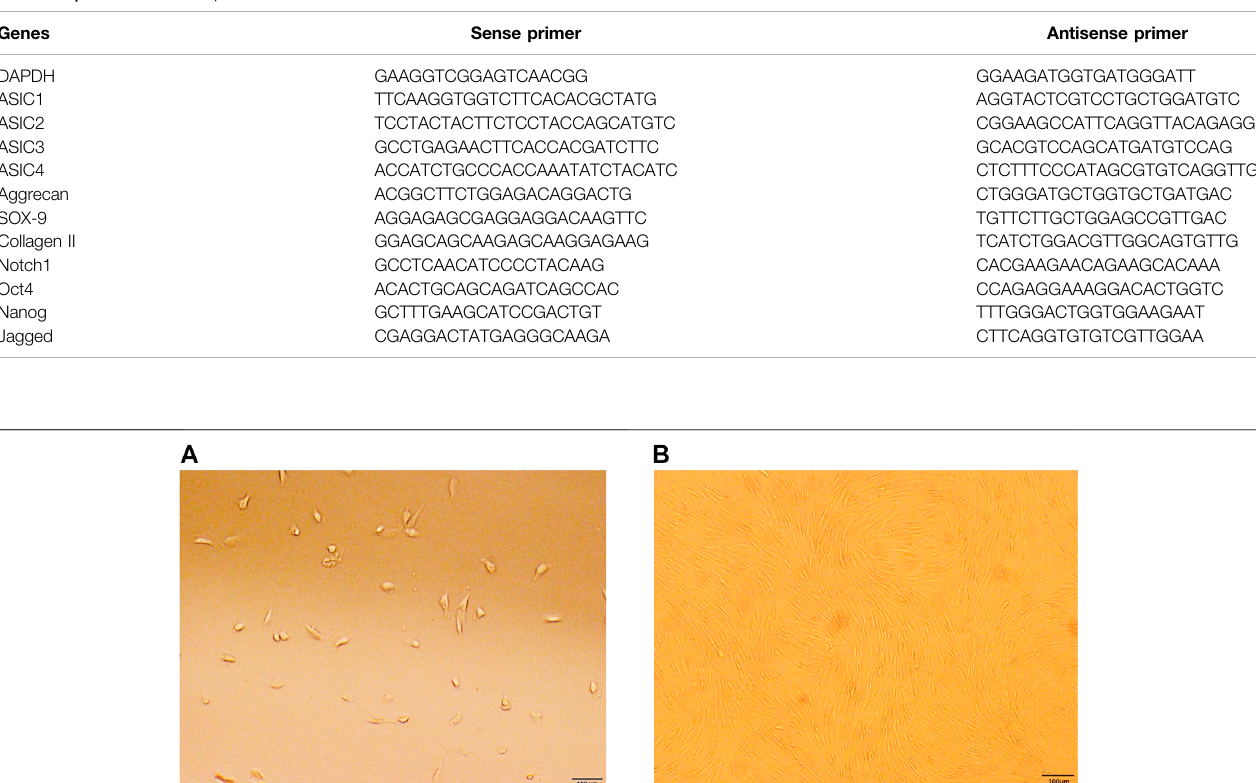
TABLE 3 | Primers used in qPCR.